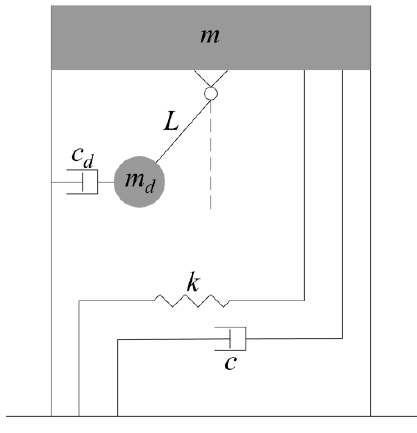
ciency. Outside of this range, the motion is not considerably influenced by the TMD system.